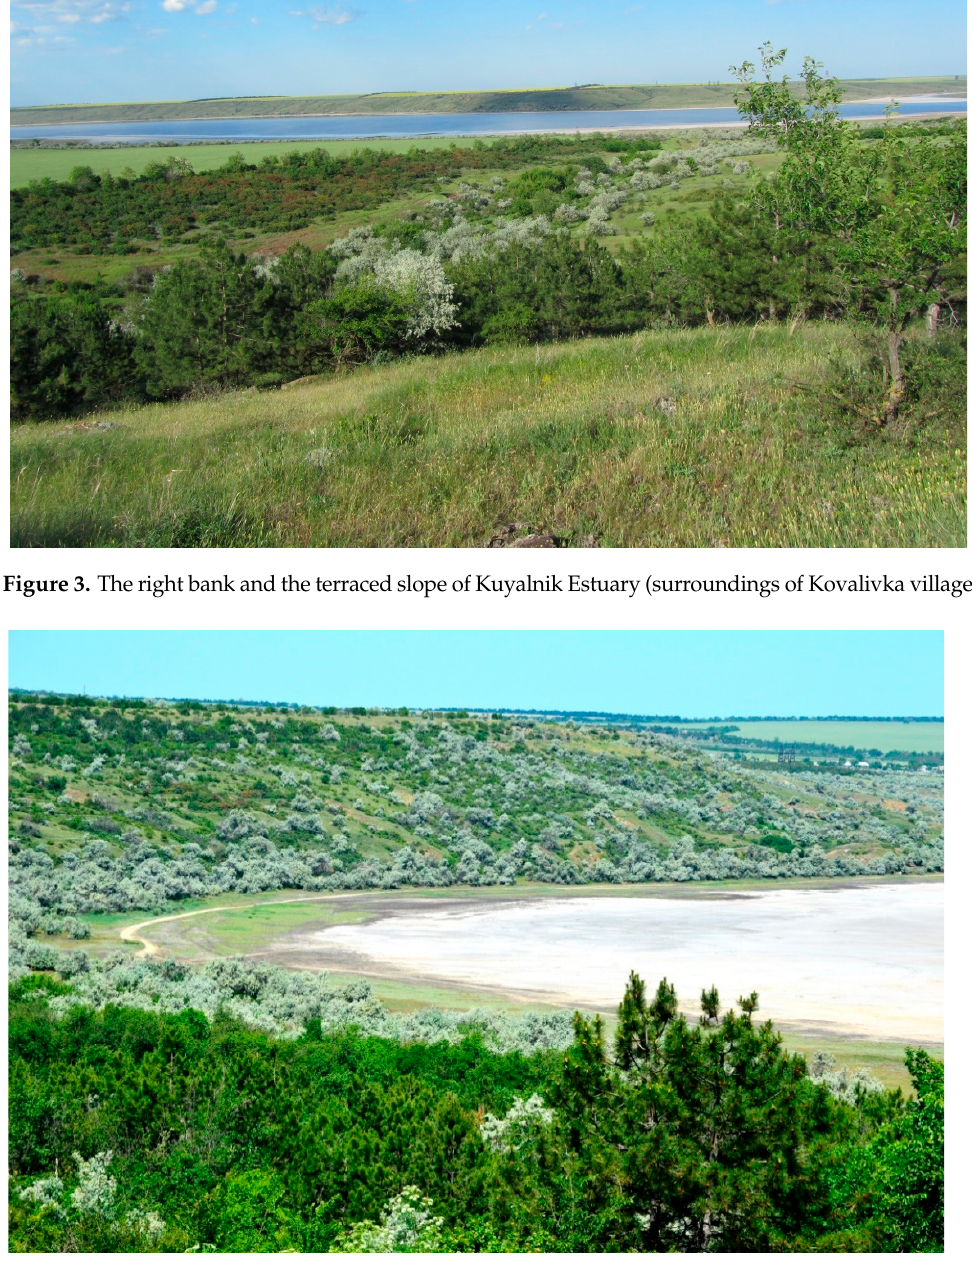
Figure 4. The left bank and the slope of Kuyalnik Estuary (surroundings of Illinka village).